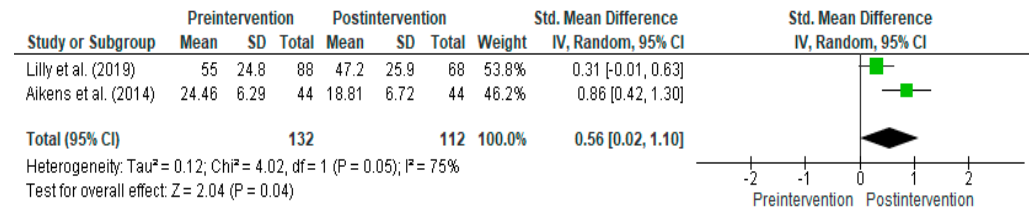
Figure 3. Meta-analysis of mindfulness in the workplace and influence on stress (attended intervention).